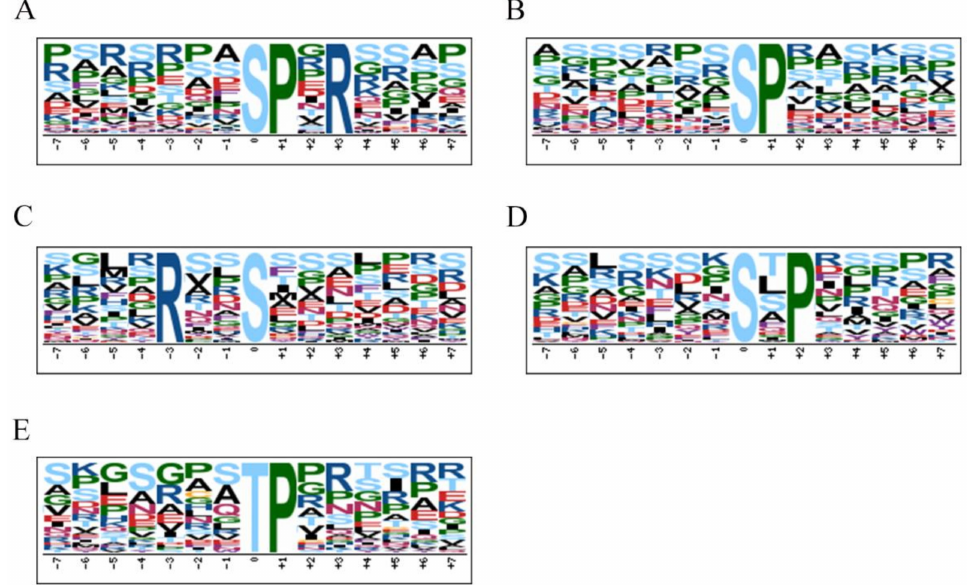
Figure 6. Phosphorylation motifs extracted from the overrepresented phosphopeptide dataset by Motif-X. ( A )–( D ) Five enriched motifs from phosphoserine; ( E ) Enriched motif from